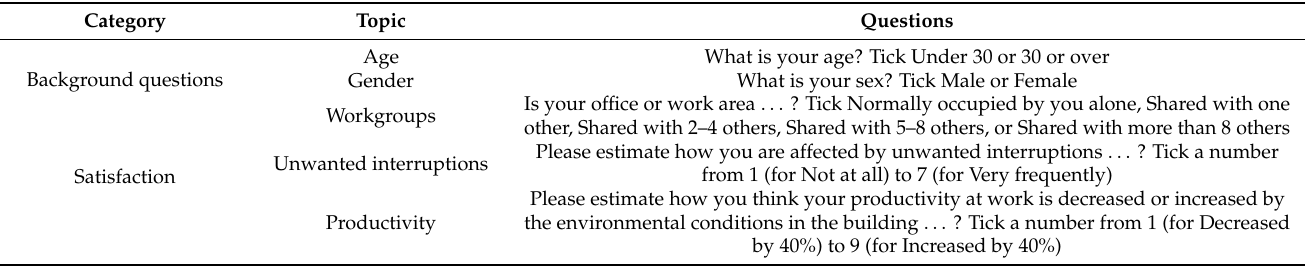
Table 3. The subset of the survey questionnaire used in this